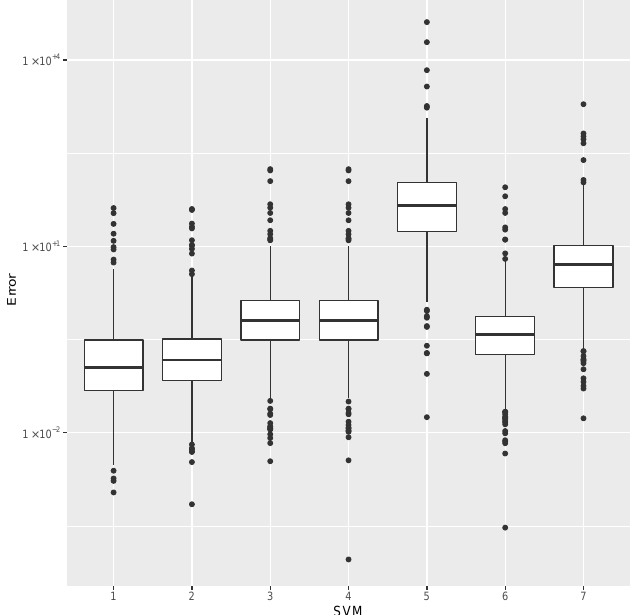
Figure 7. Error dispersion of the P critical estimate using distinct SVM kernel